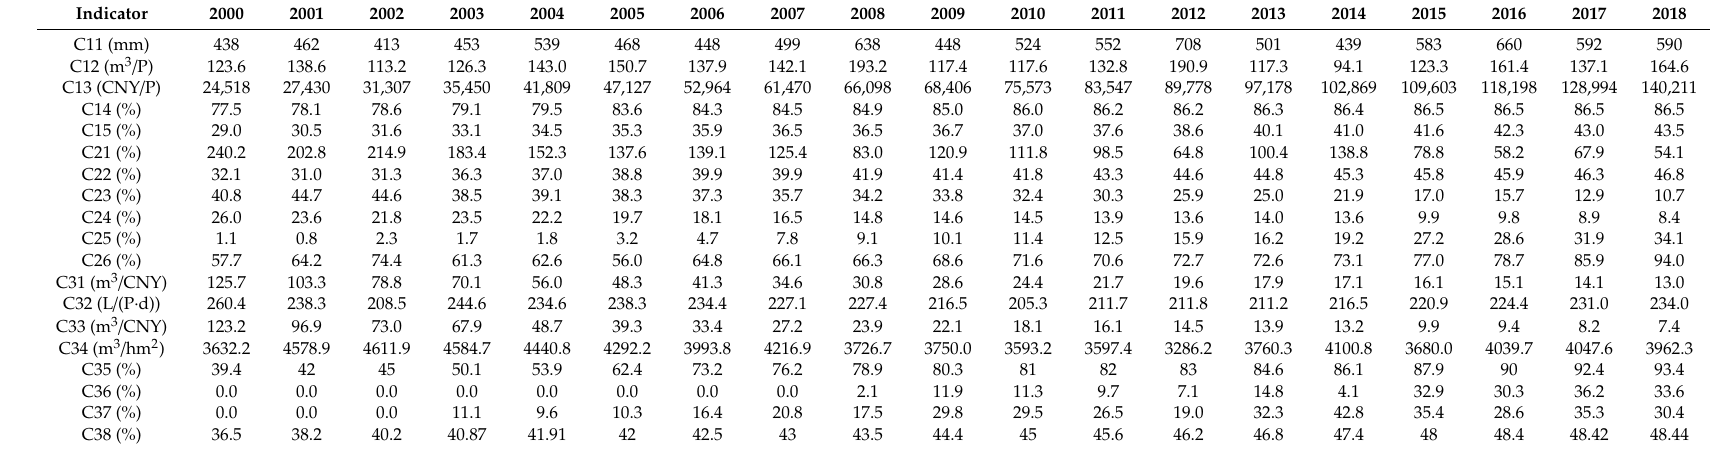
Table 6. The indicator values in the index layer of the indicator system of the Beijing